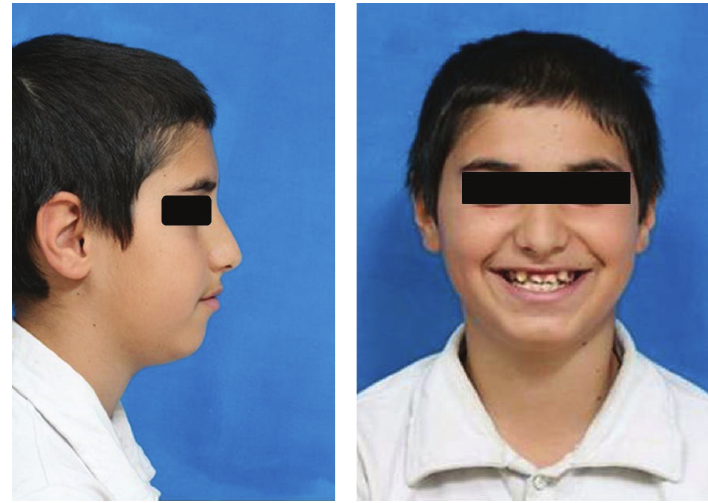
Figure 1: Pretreatment facial photography.